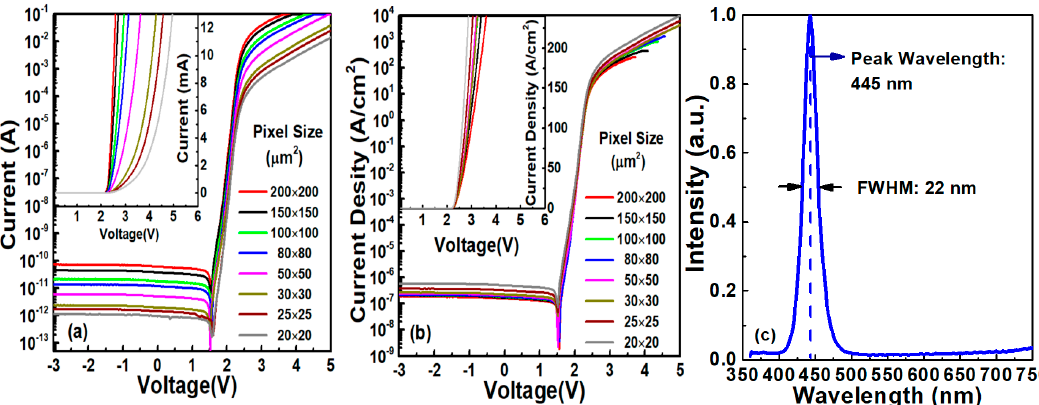
Figure 4. ( a ) I-V , ( b ) J-V characteristics of micro-LED devices with different pixel sizes, ( c ) EL spectrum.